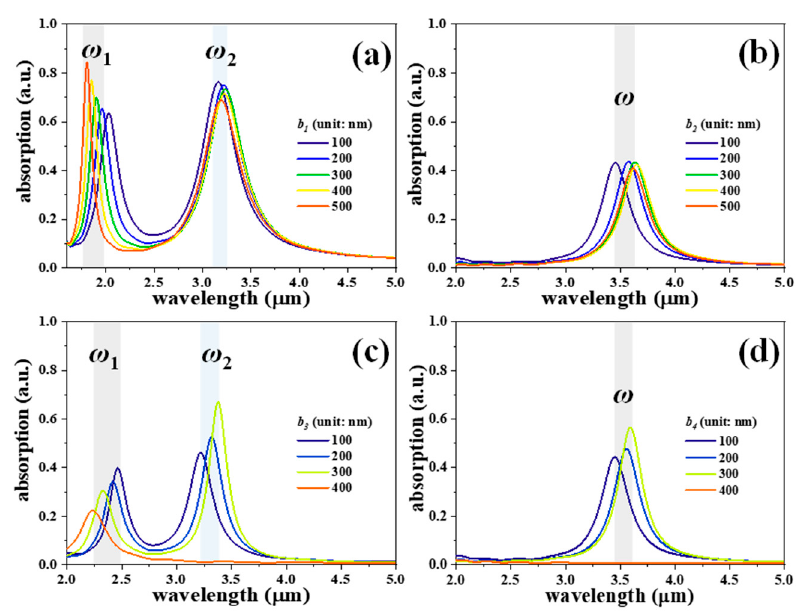
Figure 3. Absorption spectra of ( a ) SDM-1, ( b ) SDM-2, ( c ) SDM-3, and ( d ) SDM-4 with different b values, where z and a values are kept constant as z =100 nm, and a = 300 nm, respectively. To test the SDMs’ possession of active tunability, the top SDM nanostructures are suspended and connected to the MEMS actuators for the changing z values of the SDMs.